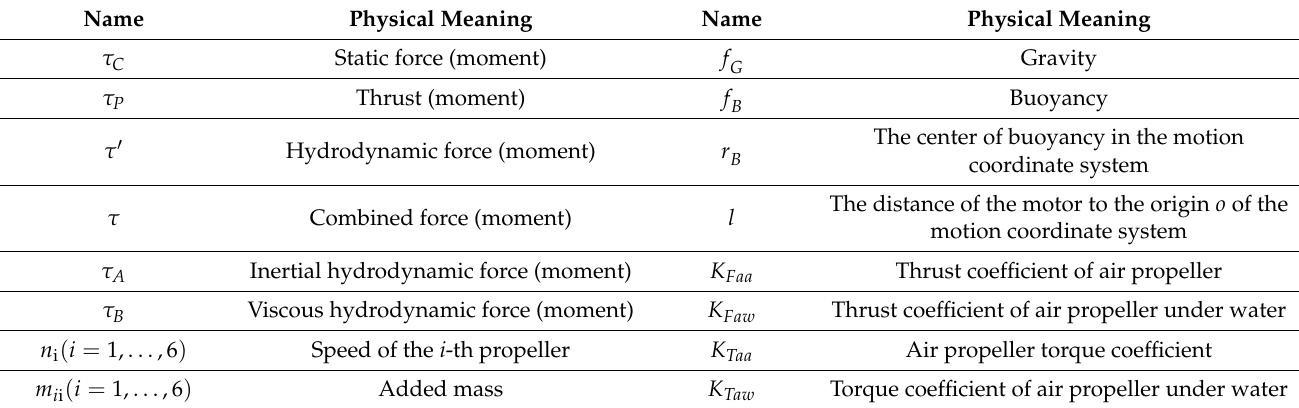
Table 2. Description of related physical